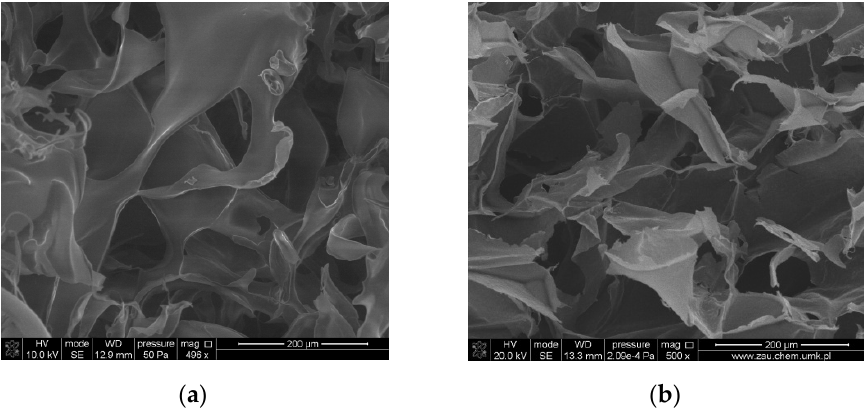
Figure 7. SEM images of ( a ) CTS/Coll; ( b ) CTS/Coll/5HA composites. [68], Copyright 2020. Reproduced with permission from Elsevier Ltd. (CTS = chitosan; Coll = collagen; HA = hyaluronic acid).